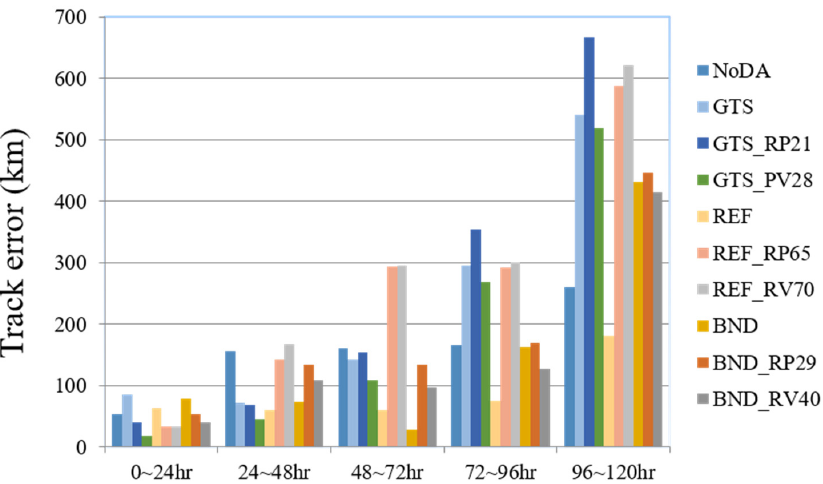
Figure 9. The daily-averaged forecast track errors (km) (average forecast errors at every six hours in the day) in five days against the best track for all experiments.